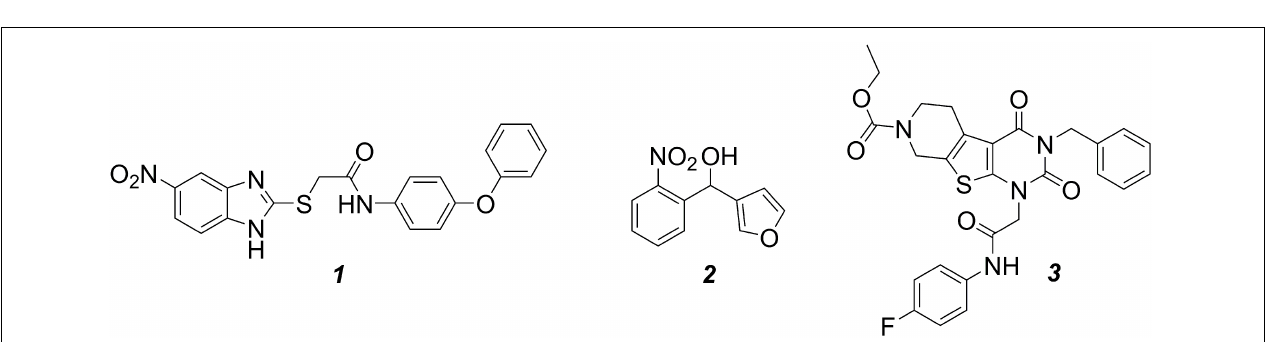
FIGURE 1 | Current model of the biosynthetic pathway of MvfR-related small molecules. AA, anthranilic acid; CoASH, Coenzyme A; MCoA, malonyl-CoA; 2-ABA-CoA, 2 (cid:48) -aminobenzoylacetyl-CoA; 2-ABA, 2 (cid:48) -aminobenzoylacetate; DHQ, dihydroxyquinoline; 2-AA, 2 (cid:48) -aminoacetophenone; 2-HABA, 2 (cid:48) -hydroxylaminobenzoylacetate; HHQ, 4-hydroxy-2-heptylquinoline; HQNO, 4-hydroxy-2-heptylquinoline-N-oxide; PQS, Pseudomonas Quinolone Signal.